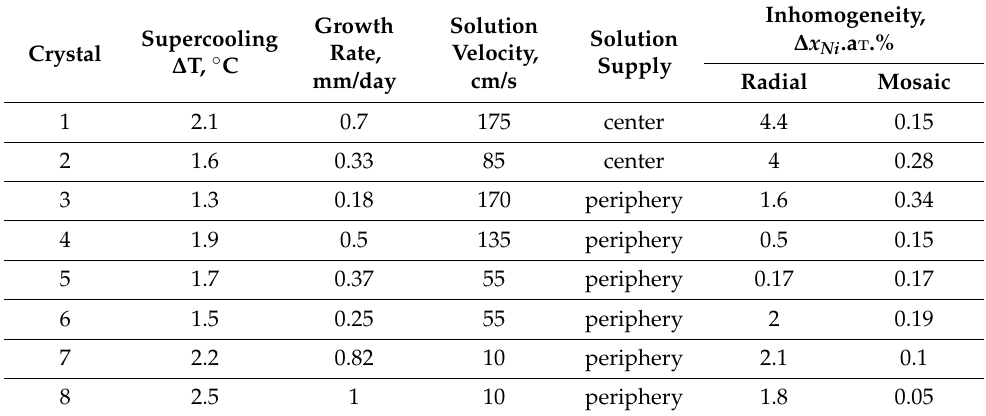
Table 1. Data on inhomogeneities of KCNSH crystals in various growth conditions.